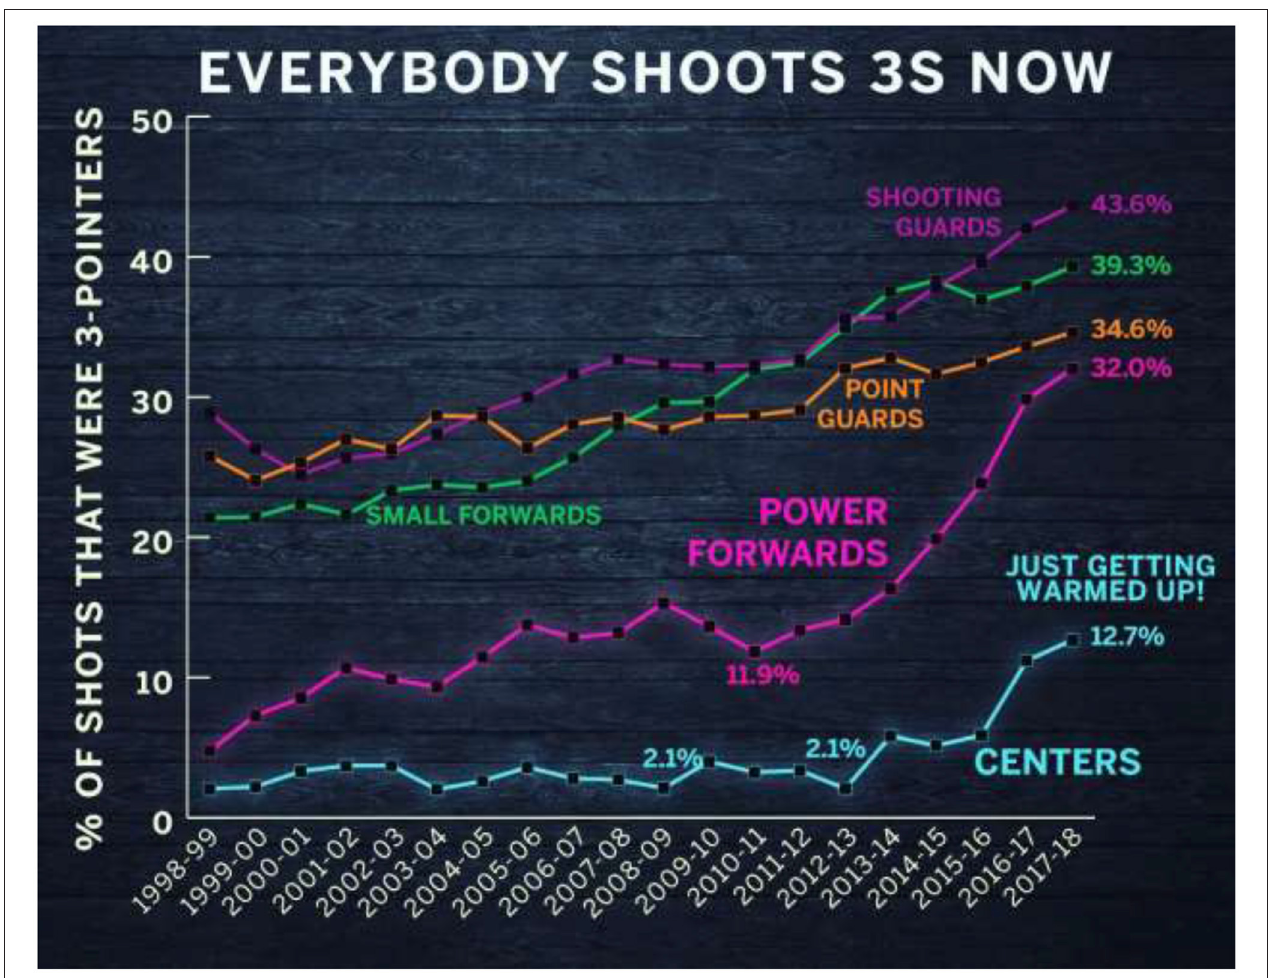
FIGURE 1 | Analytics analysis of shifting structure of NBA games—an increasing shift to 3-point shots. Source: Reprinted with permission of Goldsberry (2019).